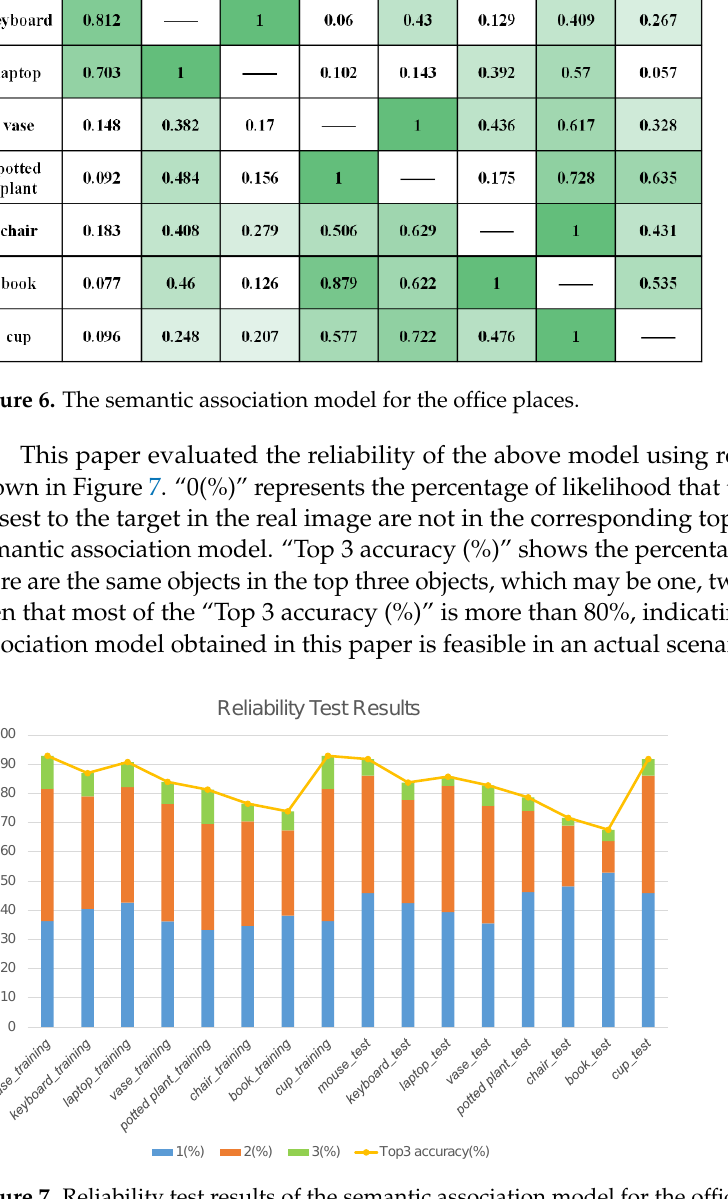
Figure 8. The semantic association model for the kitchen places. Taking the “bottle” as an example, its semantic correlation value with “wine glass” is 1 and the value with “bowl” is 0.694. By comparing these values, it can be concluded that the probability of “a wine glass is near a bottle” is greater than that of “an oven is near around a bottle”. In addition, accor ding to the experimental results, the semantic relevance between “wine glass”, “bottle” , and “bowl” is obviously higher, which is ap- parent in our daily lives. The reliability test results of the above model are shown in Figure 9. Similarly, the “Top 3 accuracy (%)” of most of the objects is over 80%, indicating that the semantic asso- ciation model is highly reliable.